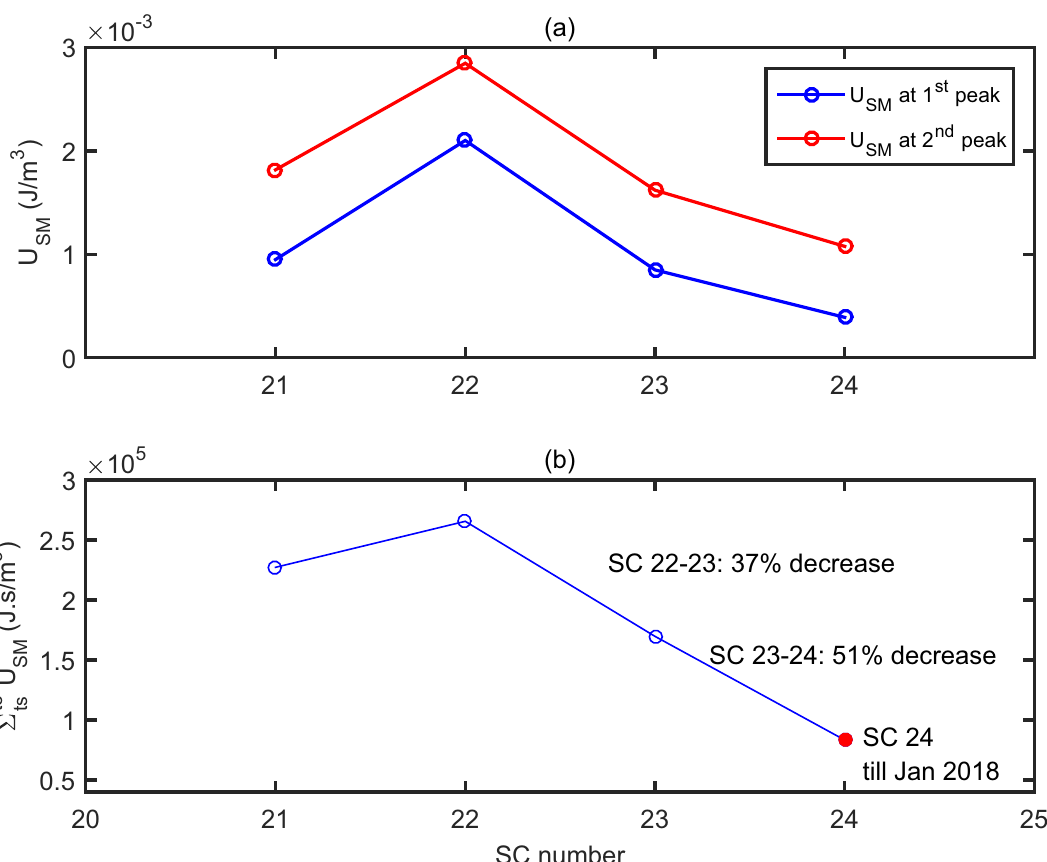
Fig. 2. (a) Variation of magnitude of 1st and 2nd peak in the SMED for SCs 21–24, (b) the integrated solar magnetic energy for SCs 21–24. U SM for SC 24 (shown by red solid circle) represents the integrated energy density till January The value R t e t s